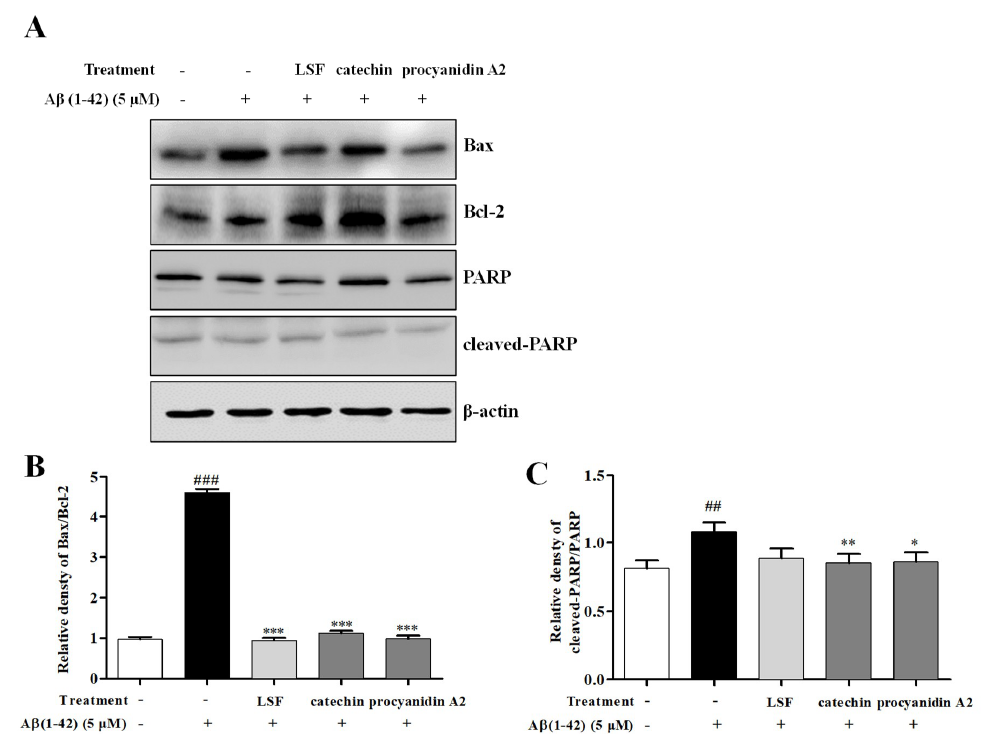
Figure 7. Catechin and procyanidin A2 inhibit cell apoptosis in the A β (1-42)-induced BV-2 cells. BV-2 cells were pretreated with 5 µ M A β (1-42) for 12 h, followed by incubations of LSF (0.469 µ g/mL), catechin (10 µ M), and procyanidin A2 (10 µ M) for another 12 h. ( A ) After treatment, cell lysates were harvested and subsequently employed for Bax, Bcl-2 PARP, and cleaved-PARP detections using Western blotting. Band intensities of Bax/Bcl-2 ( B ) and cleaved-PARP/PARP ( C ) were quantified using Image J software and normalized to β -actin. Bars are representatives of three independent experiments. BV-2 cells treated with medium alone were set as the control group, and BV-2 cells treated with 5 µ M A β (1-42) alone were set as the A β group. ## p < 0.01, ### p < 0.001 vs. control group; * p < 0.05, ** p <